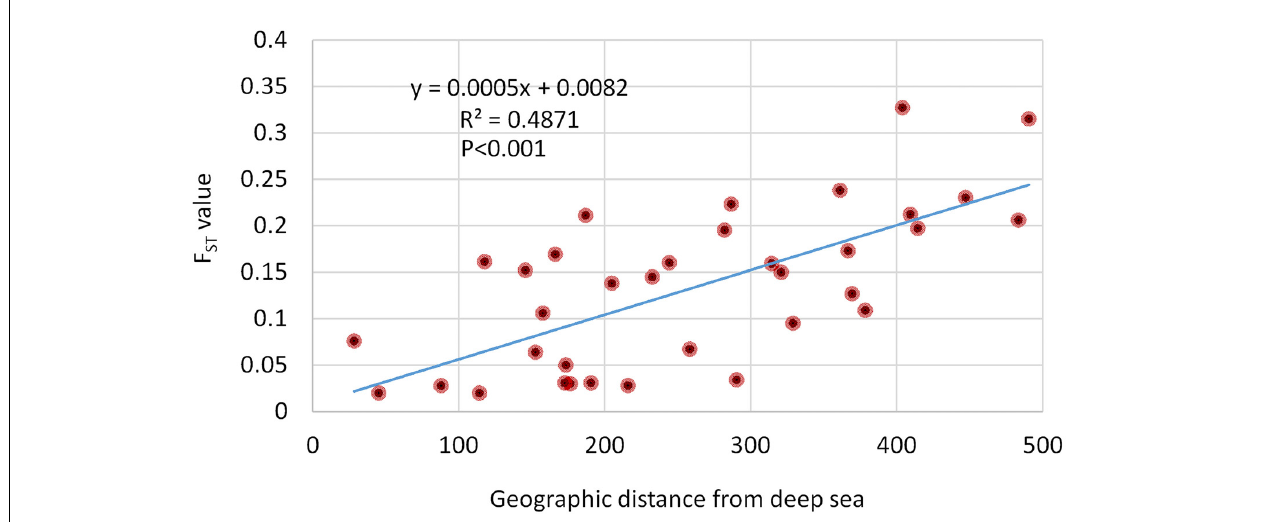
FIGURE 7 | The regression plot between the pairwise F ST values of 74 putatively adaptive SNP loci and the geographical distances of Hilsa shad Tenualosa ilisha collection sites associated with the spatial environmental heterogeneity. The Mantel test showed highly significant effects based on 9999